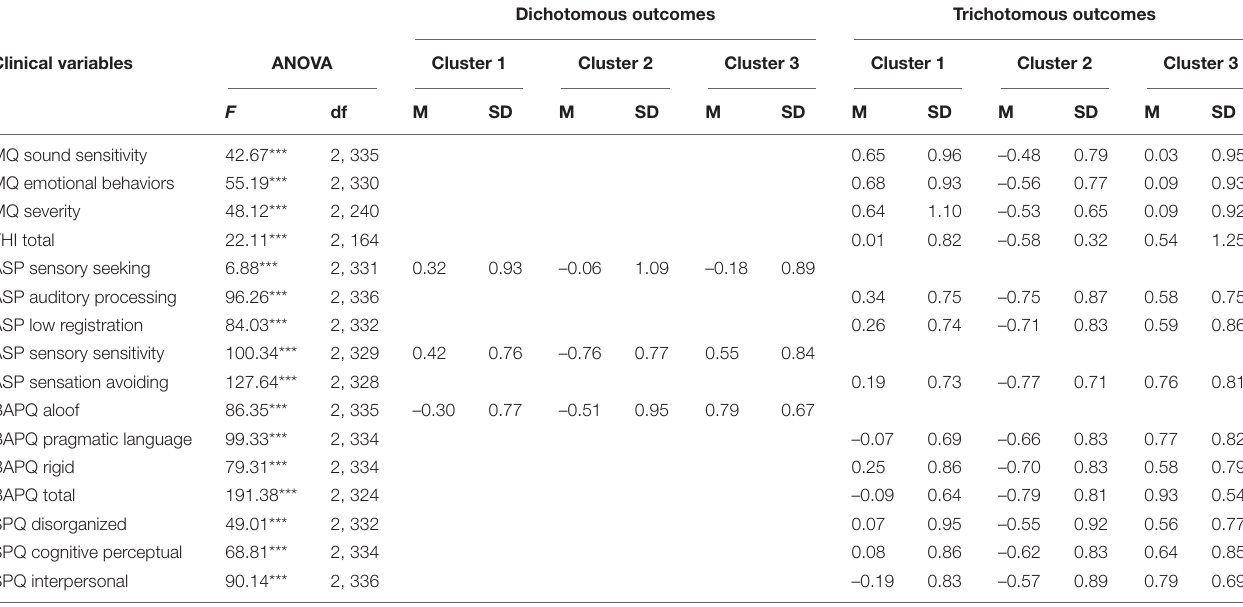
TABLE 5 | Clustering behavior and ANOVA results for variables entered into the K-means cluster analysis based on the three-cluster solution. Dichotomous outcomes